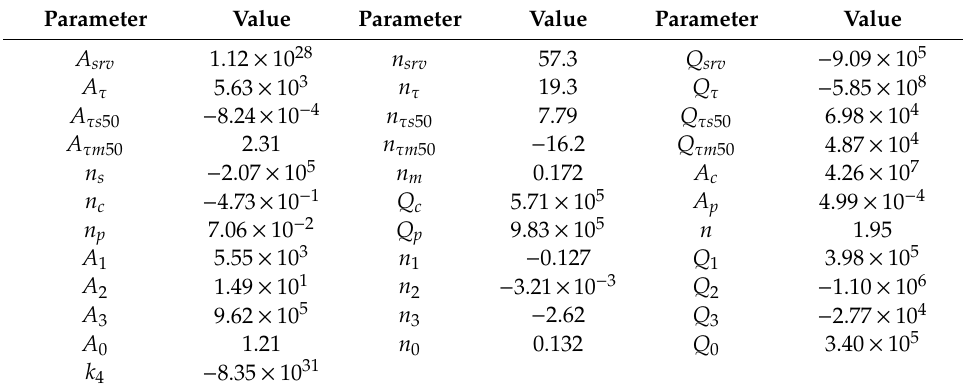
Table 2. Flow-stress model parameters of 300M